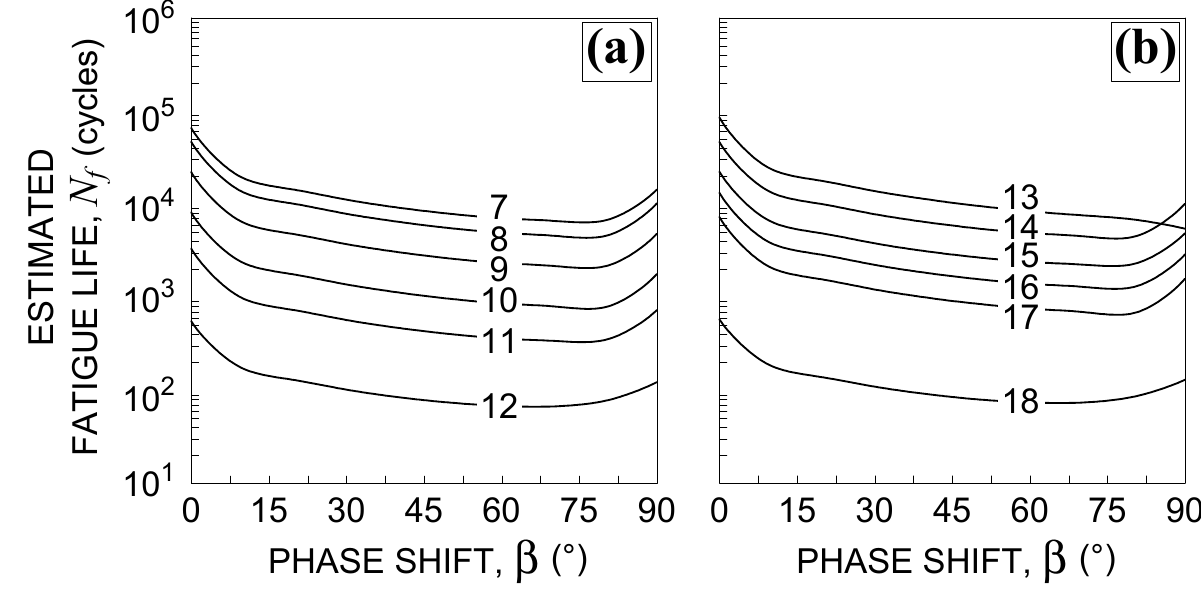
Figure 5. Influence of the phase shift β ( 0 ◦ ≤ β ≤ 90 ◦ ) on fatigue life estimation using the Borodii et al. method [3–5] for the loading conditions: ( a ) Nos. 7–12 and ( b ) Nos. 13–18, in Table 2. Such a trend does not capture the experimental evidence that recognizes 90° out-of- phase loading as the most damaging loading path.